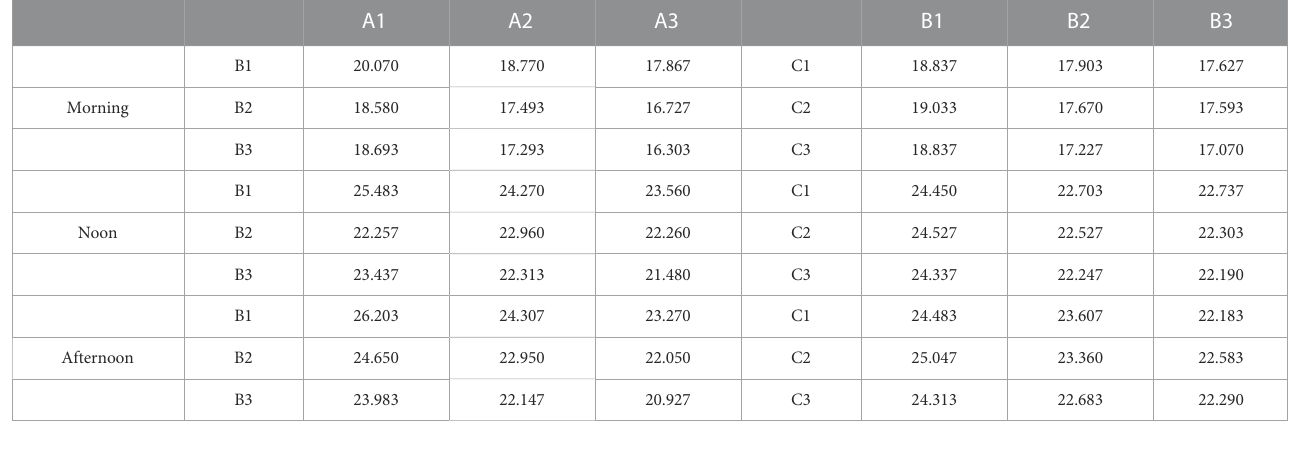
TABLE 11 Calculation of interactions between A and B, B and C in summer.